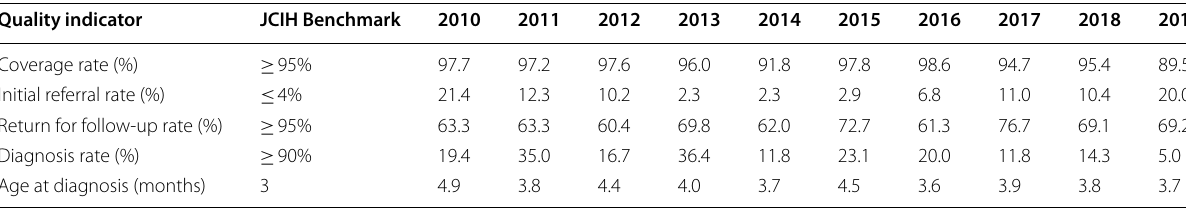
Table 3 Quality indicators from 2010 to